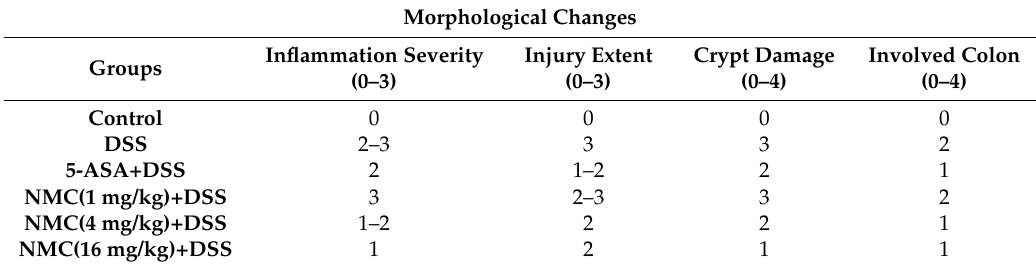
Figure 3. Effects of NMC on histological changes of colonic tissue in DSS-induced mouse colitis. Section were stained with hematoxylin and eosin: ( A ) control; ( B ) DSS; ( C ) 5-ASA (100 mg/kg); ( D ) NMC (1 mg/kg); ( E ) NMC (4 mg/kg); ( F ) NMC (16 mg/kg); ( G ) histological scores. Data are expressed as mean ( n = 10 per group) ± SEM. ## p < 0.01 compared with control group; * p < 0.05, ** p < 0.01 compared with the DSS-vehicle group. Table 1. Effect of NMC on morphological signs of colonic damage observed seven days in DSS-induced colitis.